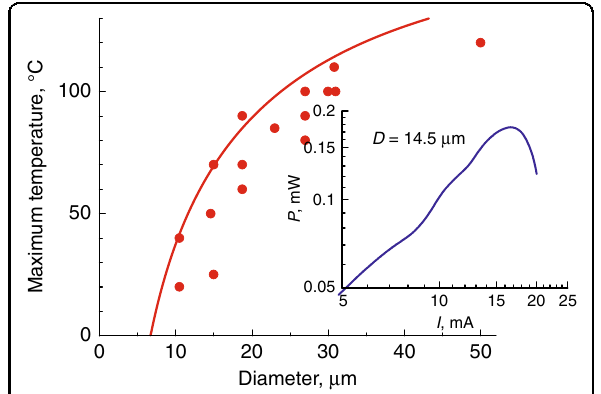
Fig. 13 CW operation of microdisk lasers. Main panel: maximum temperature of CW operation vs microdisk diameter: experiment (QWD-on-GaAs) and simulation. Inset: light — current curve in CW regime; P - power at detector, I - injection current